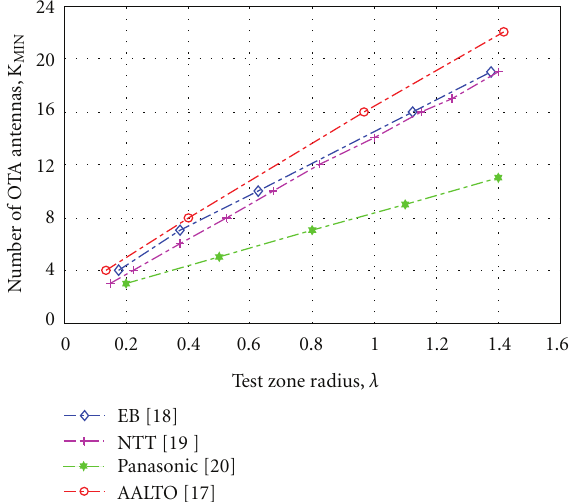
Figure 2: The number of probes as a function of the test zone radius for the multiple cluster model with uniform distributed PAS when the probes are placed equidistantly over the 360 ◦ angular region in ϕ .